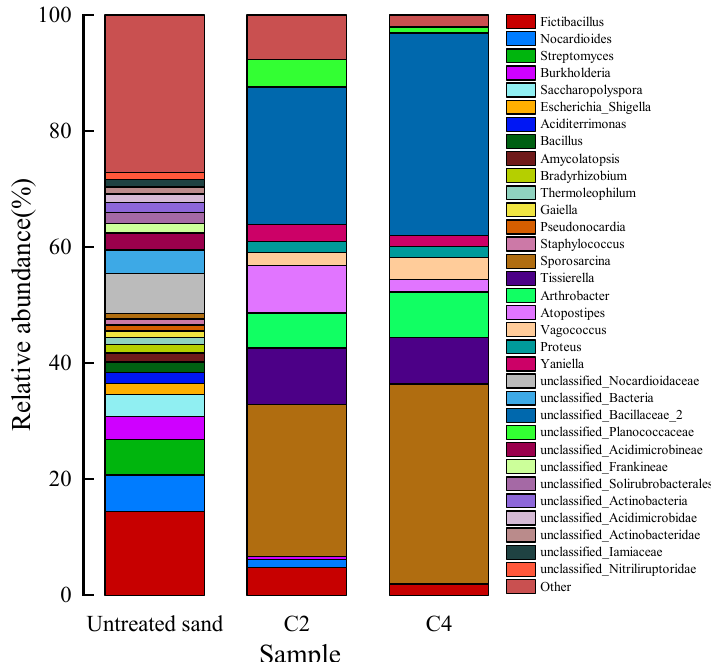
Figure 16. Relative abundance of microorganisms in different samples.